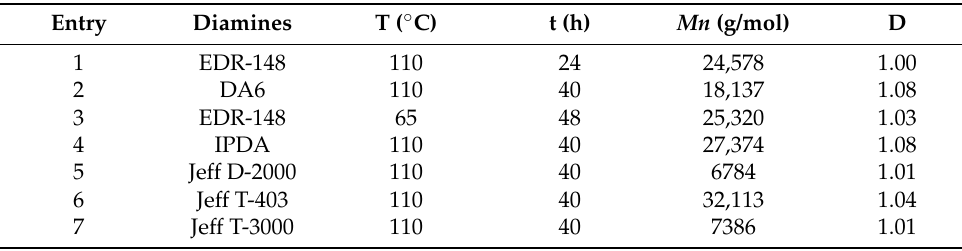
Table 4. Properties of PHURs.